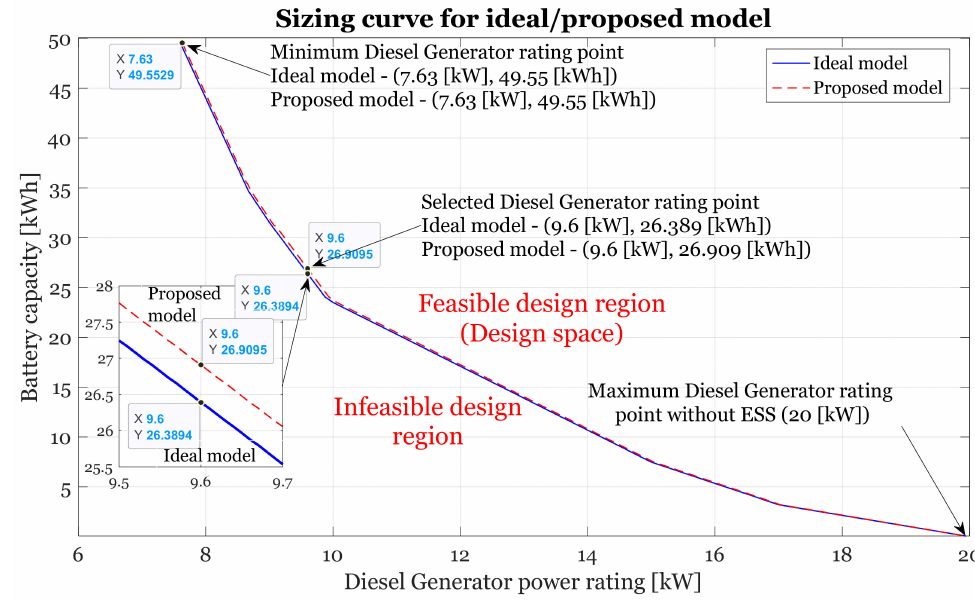
Figure 11. Pareto curve